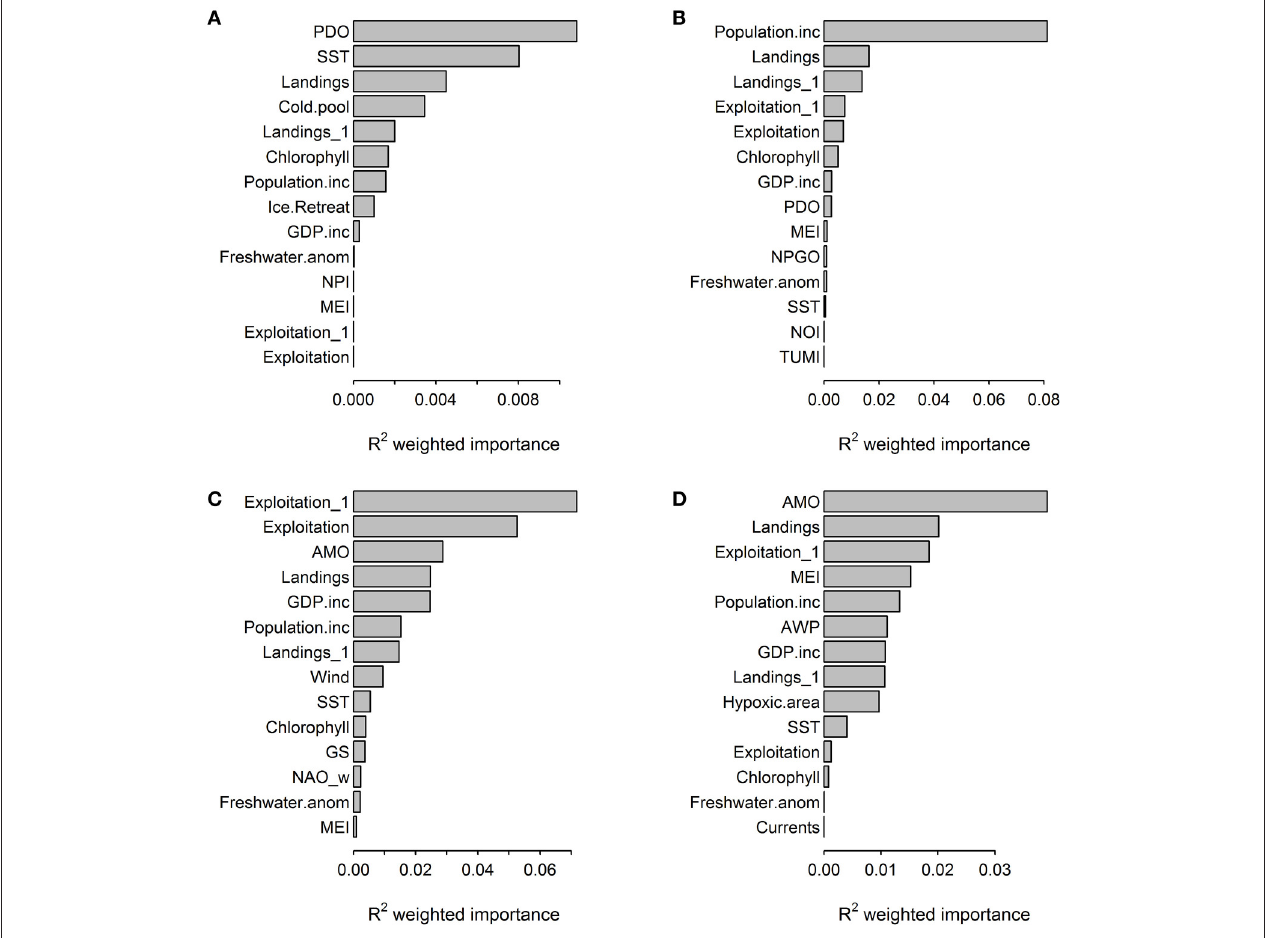
FIGURE 2 | Importance of human and environmental pressure variables across ecological indicator outputs ( R 2 ) from the gradient forest analyses for (A) Alaska, (B) California Current, (C) Northeast US, (D) Gulf of